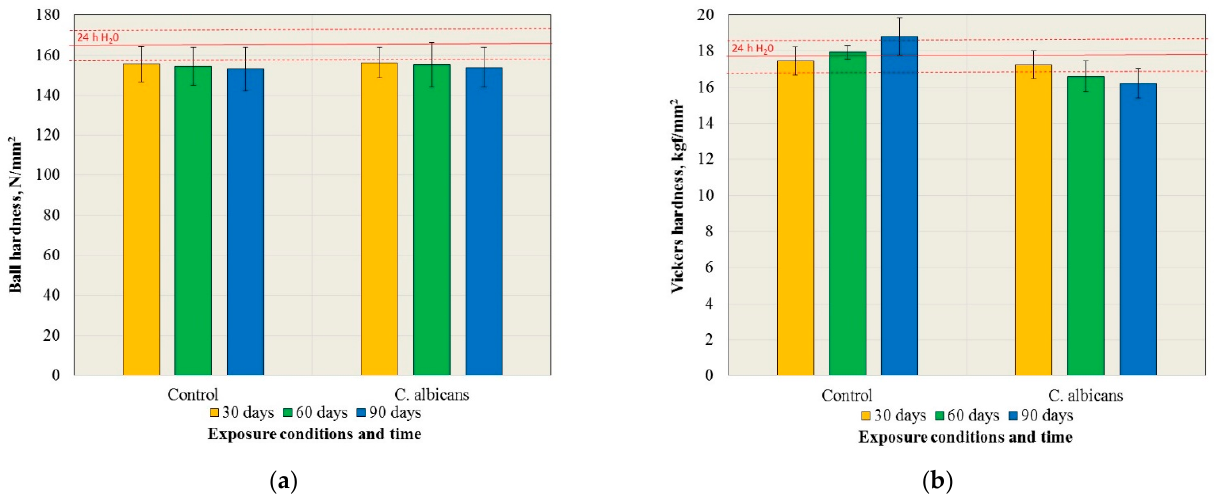
Figure 3. The mean ball hardness ( a ) and Vickers hardness ( b ) values with the standard deviations after exposure to the control medium and the C. albicans suspension.